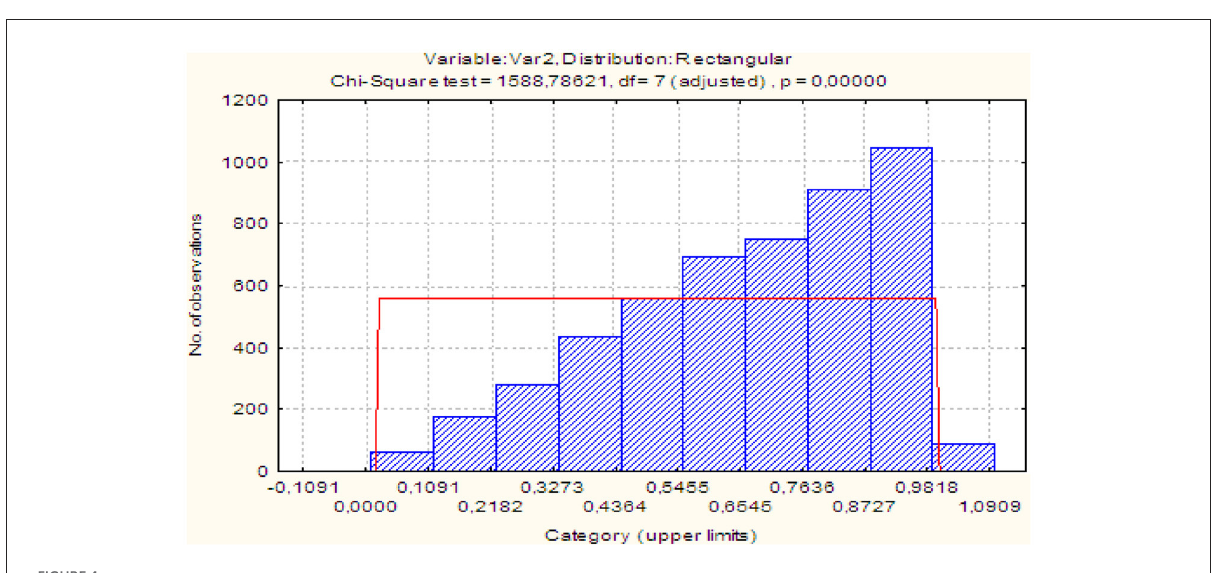
FIGURE4 Histograms of distributions of statistics x 1 ≤ x 2 of beta